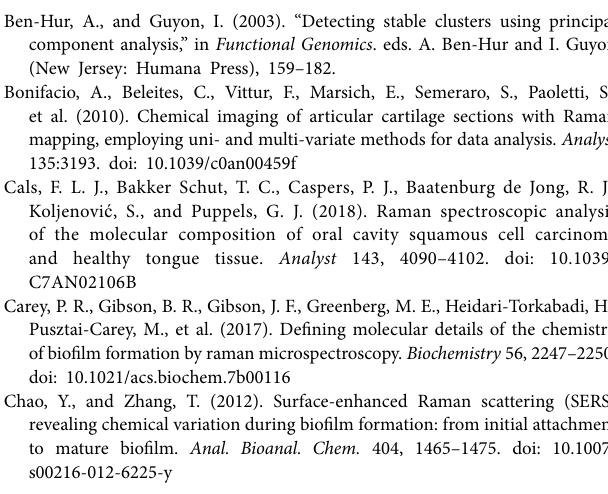
Supplementary Figure 1 | Individual Z-stack CLSM images of an in-vitro subgingival biofilm model. Z-steps size of 1.018 µm was used with specific 16S rRNA FISH probes of S. oralis (MIT447, green) and A. denticolens (ACT476, red). Magnification of 100x was